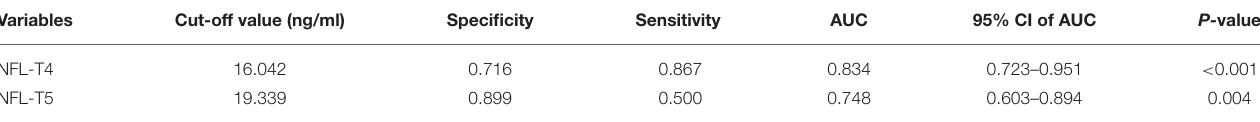
TABLE 3 | Cut-off points, sensitivities, specificities, and AUC values of NFL levels for stroke prediction by ROC analysis.